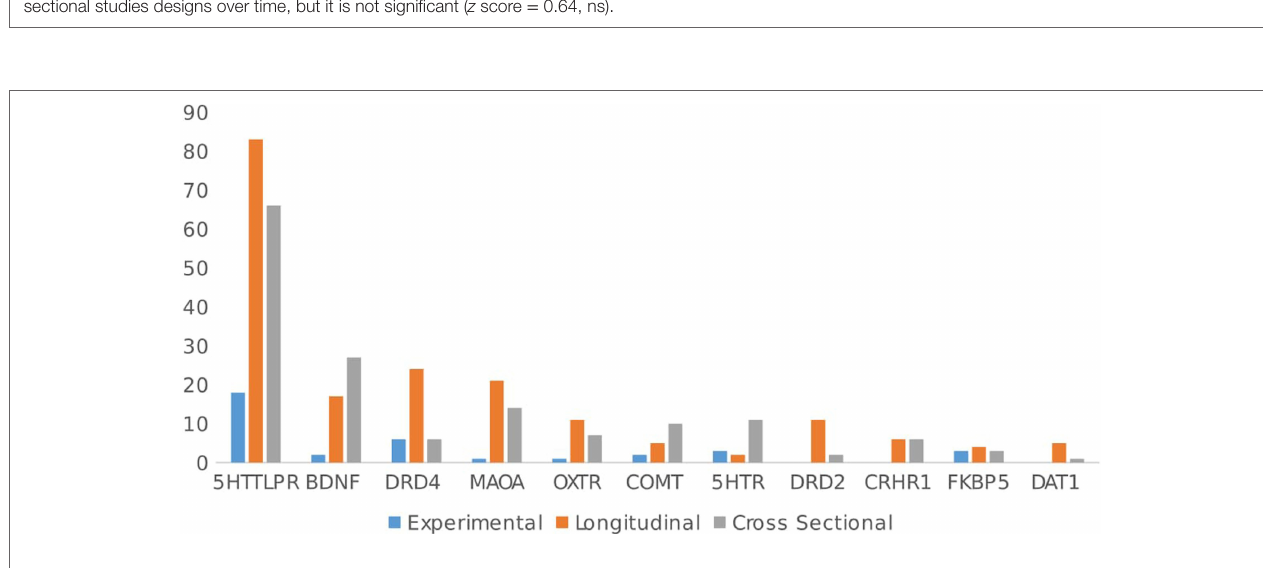
FiGURe 10 | Articles type by gene.